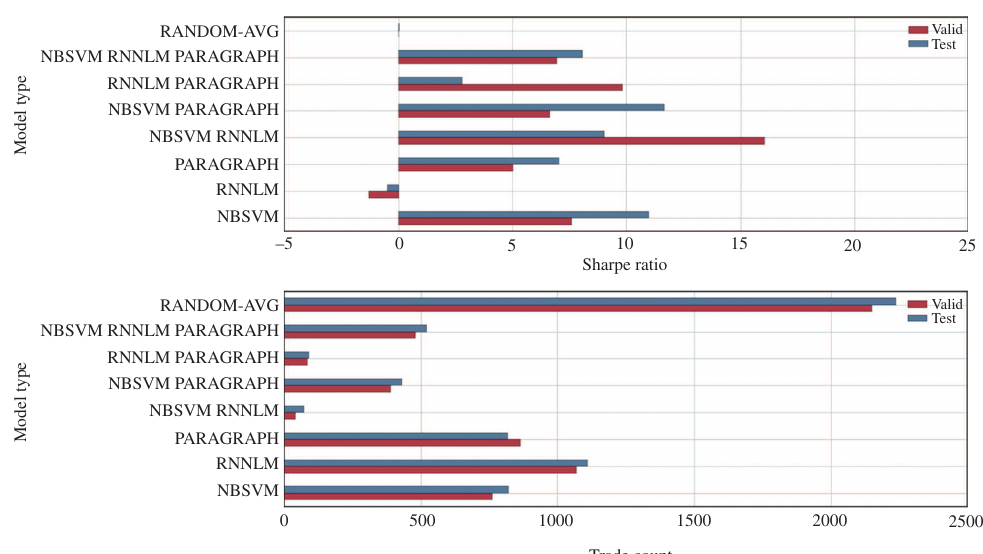
Figure 3: Performance of Language Models on 60-Min Exit Strategy.